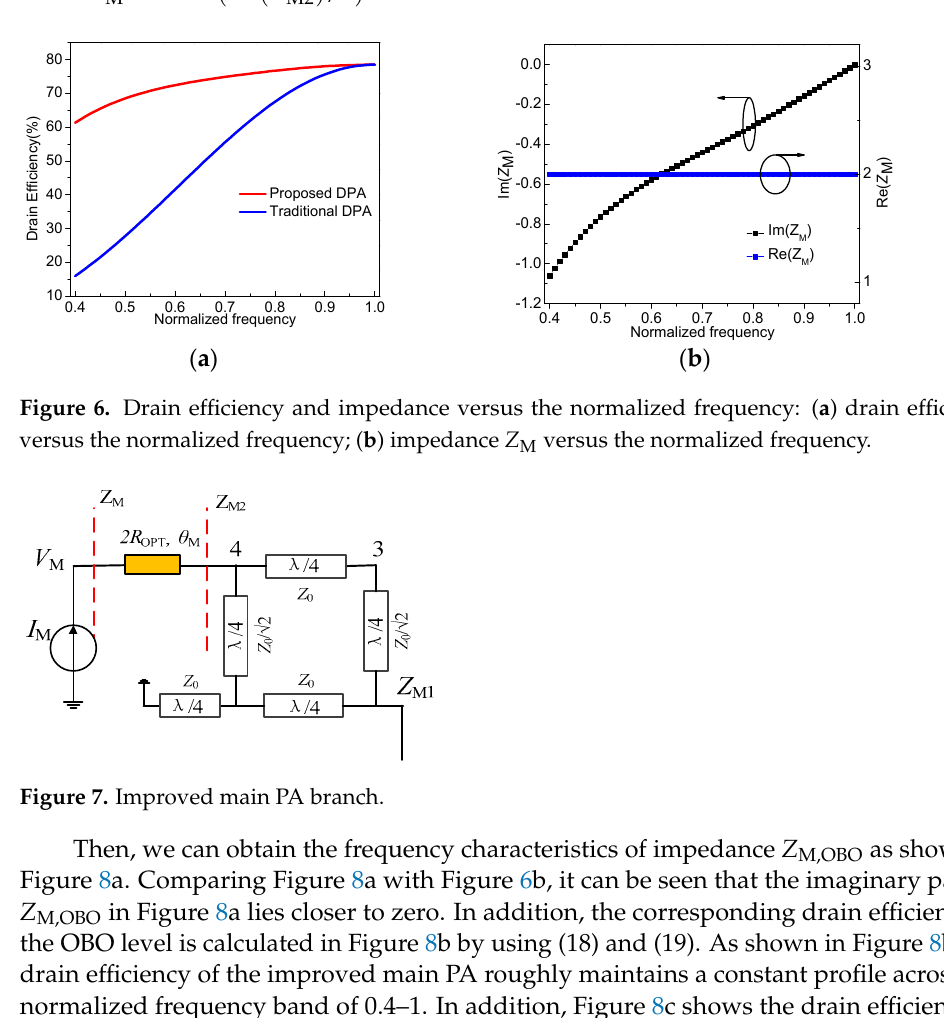
Figure 7. Improved main PA branch.